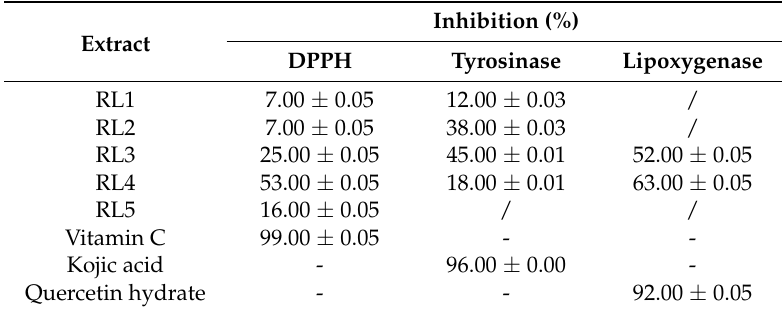
Table 1. Mean inhibitions (±SEM, n = 3) of 1-diphenyl-2-picrylhyorazyl (DPPH), tyrosinase, and lipoxygenase by the R. luteola extracts RL1 to RL5.